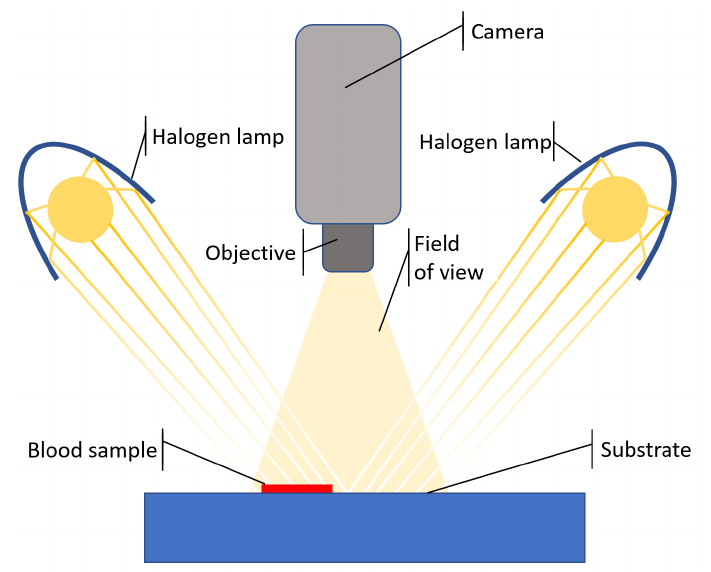
Figure 2. Hyper-spectral image acquisition setup